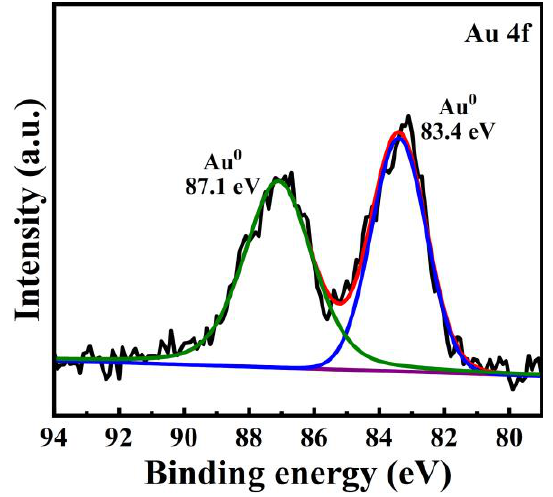
Figure 2. X-ray photoelectron spectra (XPS) of the synthesized Au@15- c rown-5 catalyst.